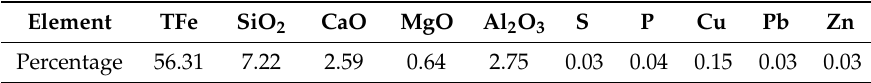
Table 7. Chemical compositions of iron concentrate (mass fraction,